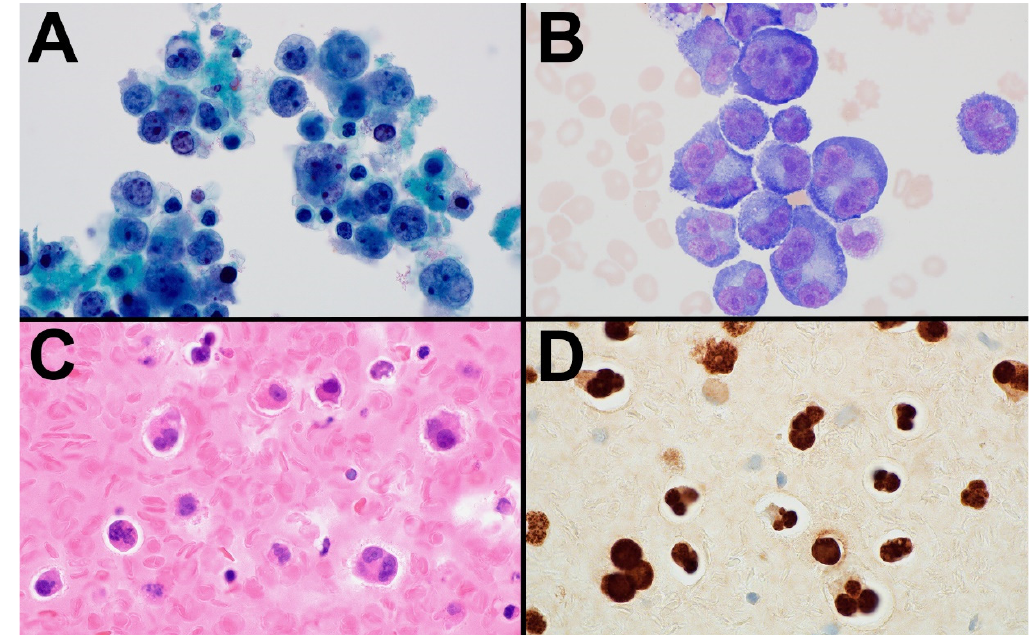
Figure 2. PEL arising in a patient who had previously received an allogeneic hematopoietic stem transplant for T-cell lymphoma. The cytospin slides ( A , B ) and cell block ( C ) of the pleural fluid in this case show a proliferation of large, pleomorphic lymphoid cells. Although some neoplastic cells have relatively round nuclear contours with prominent nucleoli, many others have a more anaplastic appearance with multinucleated forms that resemble Hodgkin/Reed-Sternberg cells. The neoplastic cells express CD138, EMA, and CD30 (Gibson, S.E., Division of Hematopathology, Department